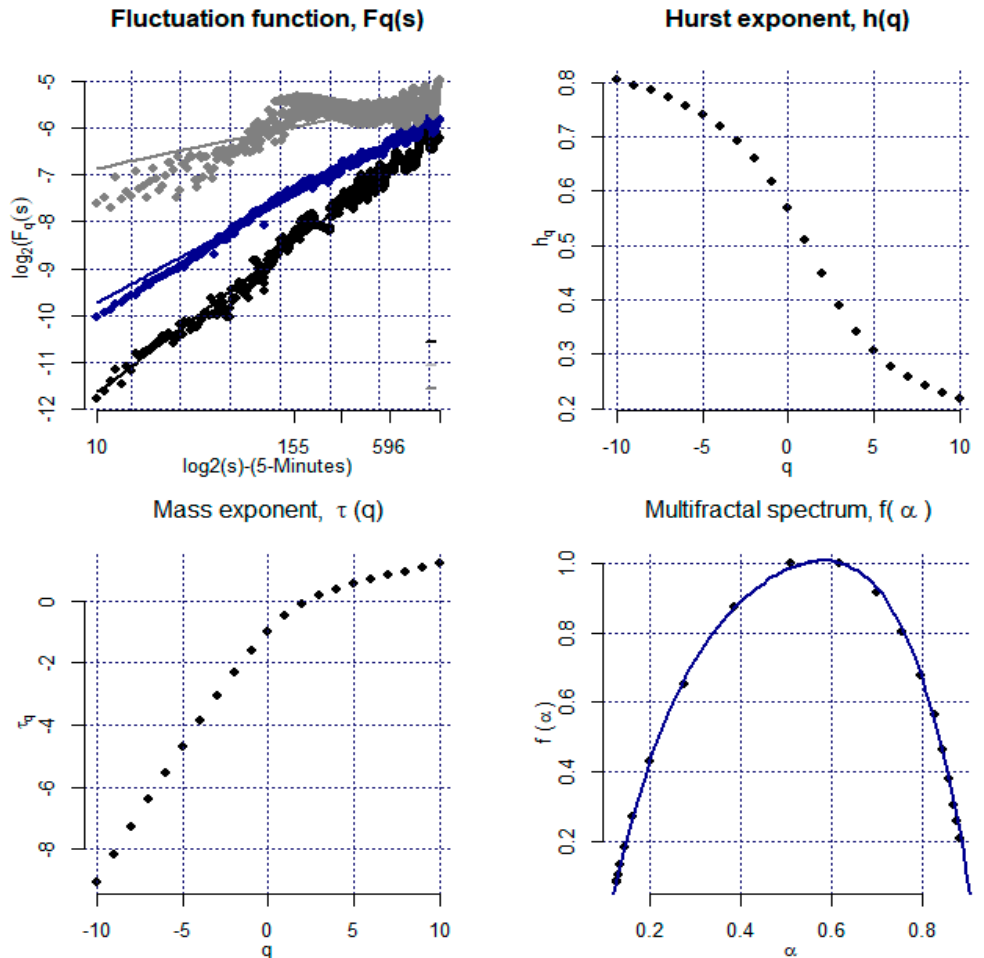
Figure 3. The MF-DFA results of intraday stock returns time series (Borsa Italian stock market index, FTSE MIB). ( Top Left ) Fluctuation functions for q = − 10, q = 0, q = 10; ( Top Right ) generalized Hurst exponent for each q ; ( Bottom Right ) Mass exponent, τ ( q ). ( Bottom Left ) Multifractal spectrum. Table 2. Generalized Hurst exponents for eight European stock markets and their range over q ∈ ( − 10, 10]. Order